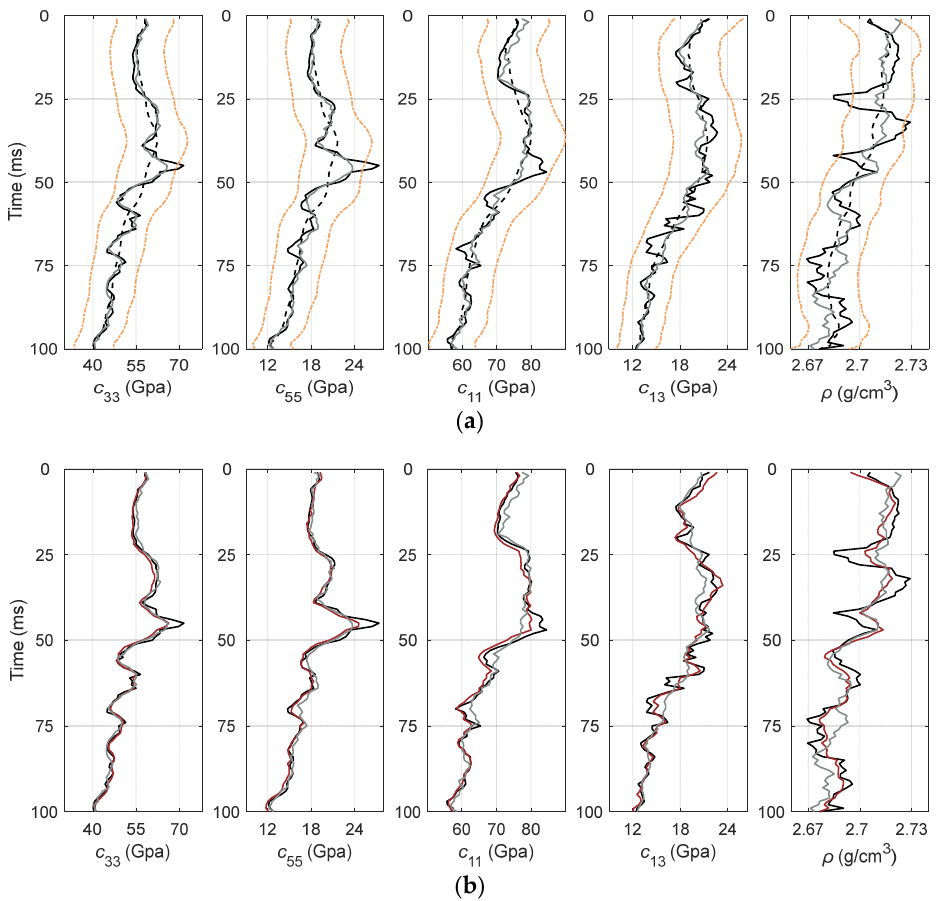
Figure 11. Nonlinear inversion result with the well model by the conventional FSA without the aid of linear inversion. ( a ) Search limit and ( b ) comparison of the results by the nonlinear inversion (gray curve) and proposed method (red curve). The black solid, black dash, and orange dash curves are the true logs, the initial model, and the search limit, respectively. The red curves are same as those in Figure